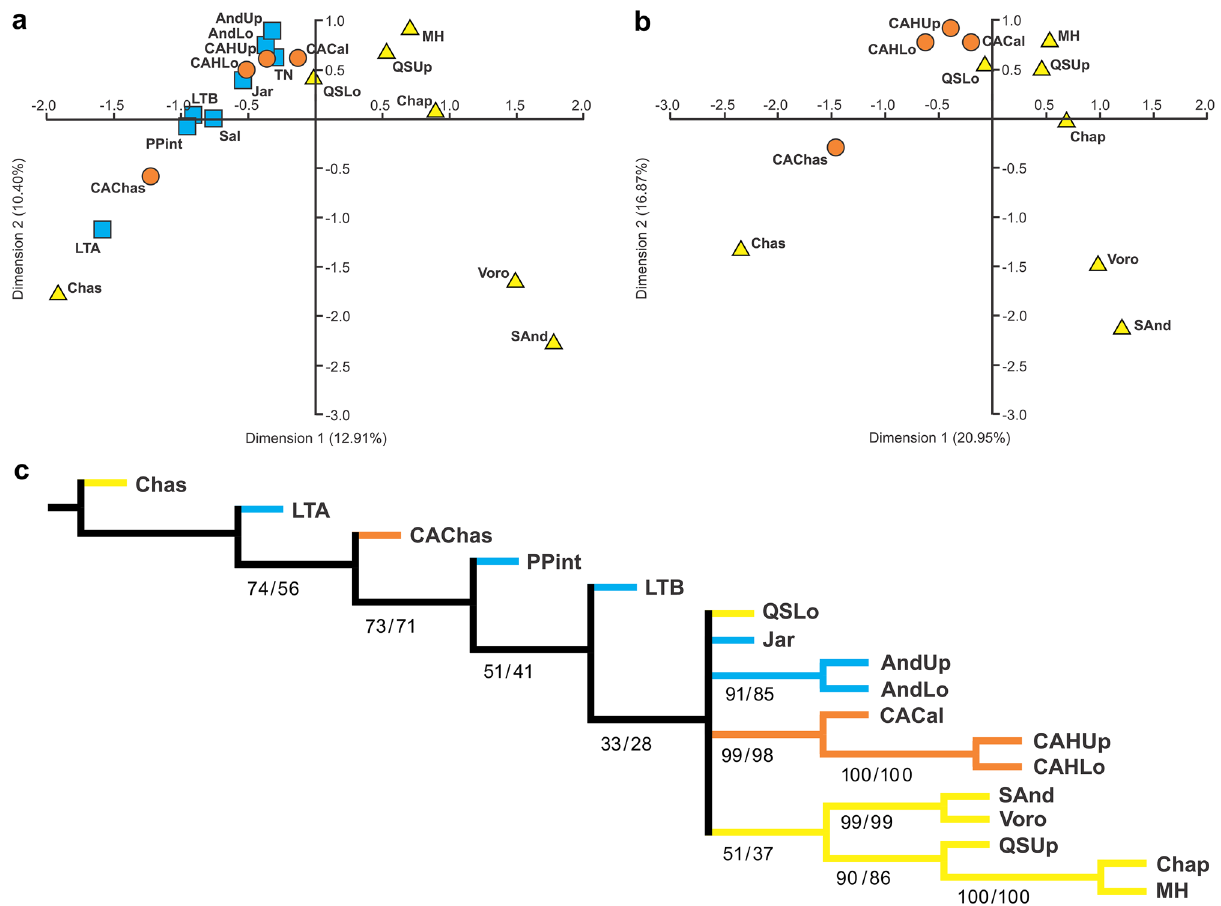
Figure 3. Faunal ordination, similarities and regionalism of the Neogene of Argentina. ( a ) Biplot of the first two axes of Correspondence Analysis (CA) using the complete sample; ( b ) biplot of the first two axes of Correspondence Analysis (CA) using the Pampean Region sample; ( c ) Parsimony Analysis of Endemicity (PAE), reduced strict consensus of four most parsimonious trees of 638 steps, excluding Sal and TN, under “standard” parsimony. Numbers below branches correspond to branch support (frequencies/difference of frequencies, respectively) . Yellow triangles (a, b) and lines (c): faunas from Buenos Aires Province; orange circles (a, b) and lines (c): faunas from La Pampa Province (both within Pampean Region); blue squares (a) and lines (c): faunas from Cuyo and Northwestern regions of Argentina. Abbreviations in Table 1. Tree in (c) was obtained with